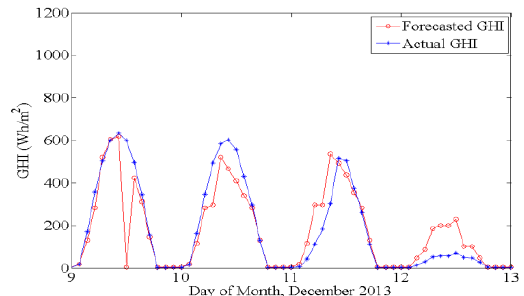
Figure 7. Comparison between two-days-ahead forecasted and actual GHI for 2 clear, 1 partly cloudy, and 1 overcast day (type 2).